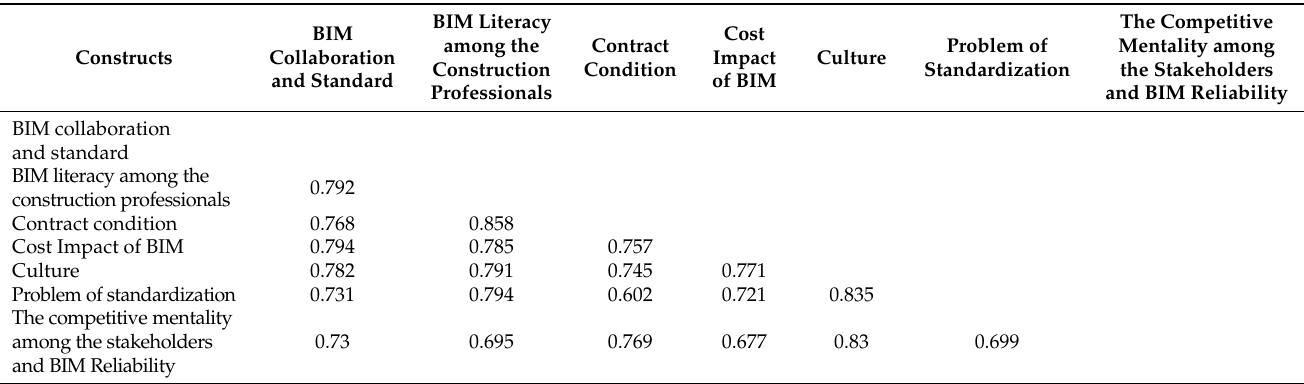
Table 8. Discriminant validity